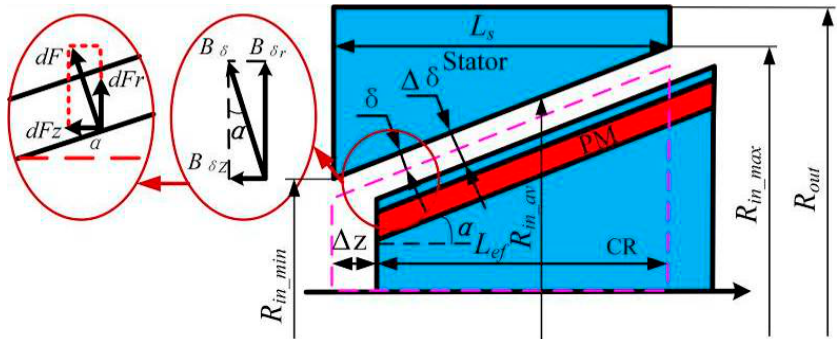
Figure 1. Profile of the conical-rotor permanent magnet synchronous motor (CR-PMSM).